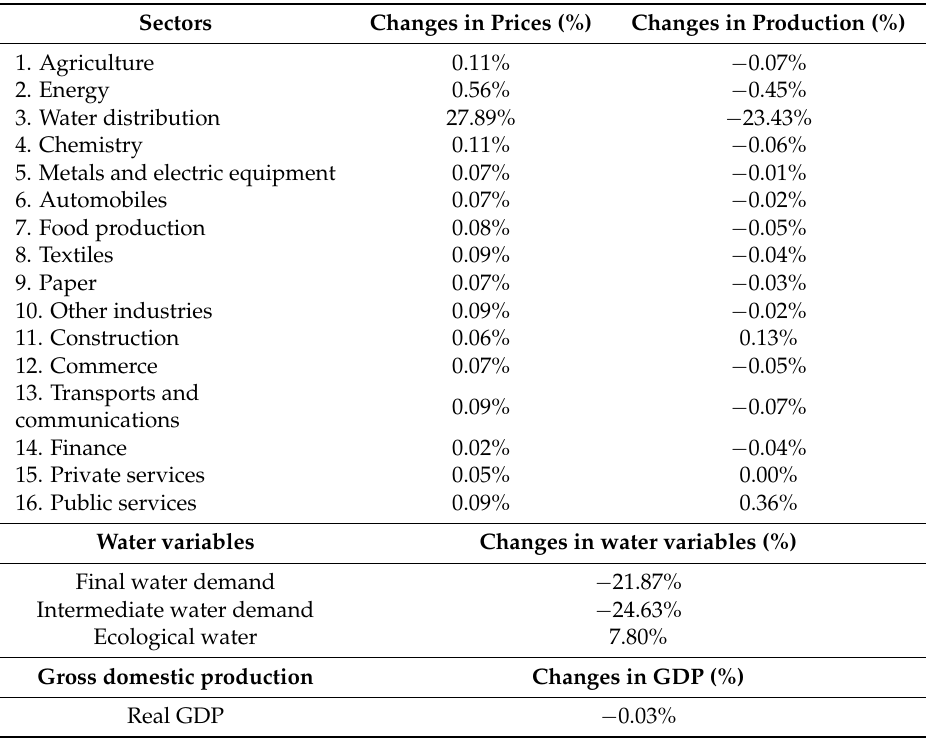
Table 4. Simulation 4: 25% tax on water price (with water